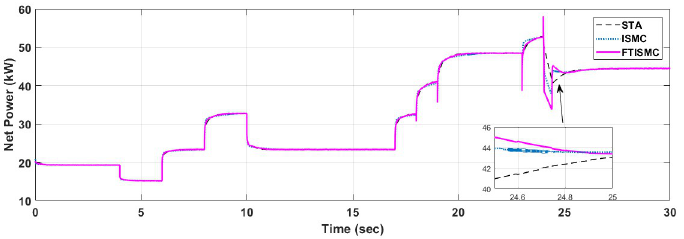
Fig 7. Net power produced by PEM fuel